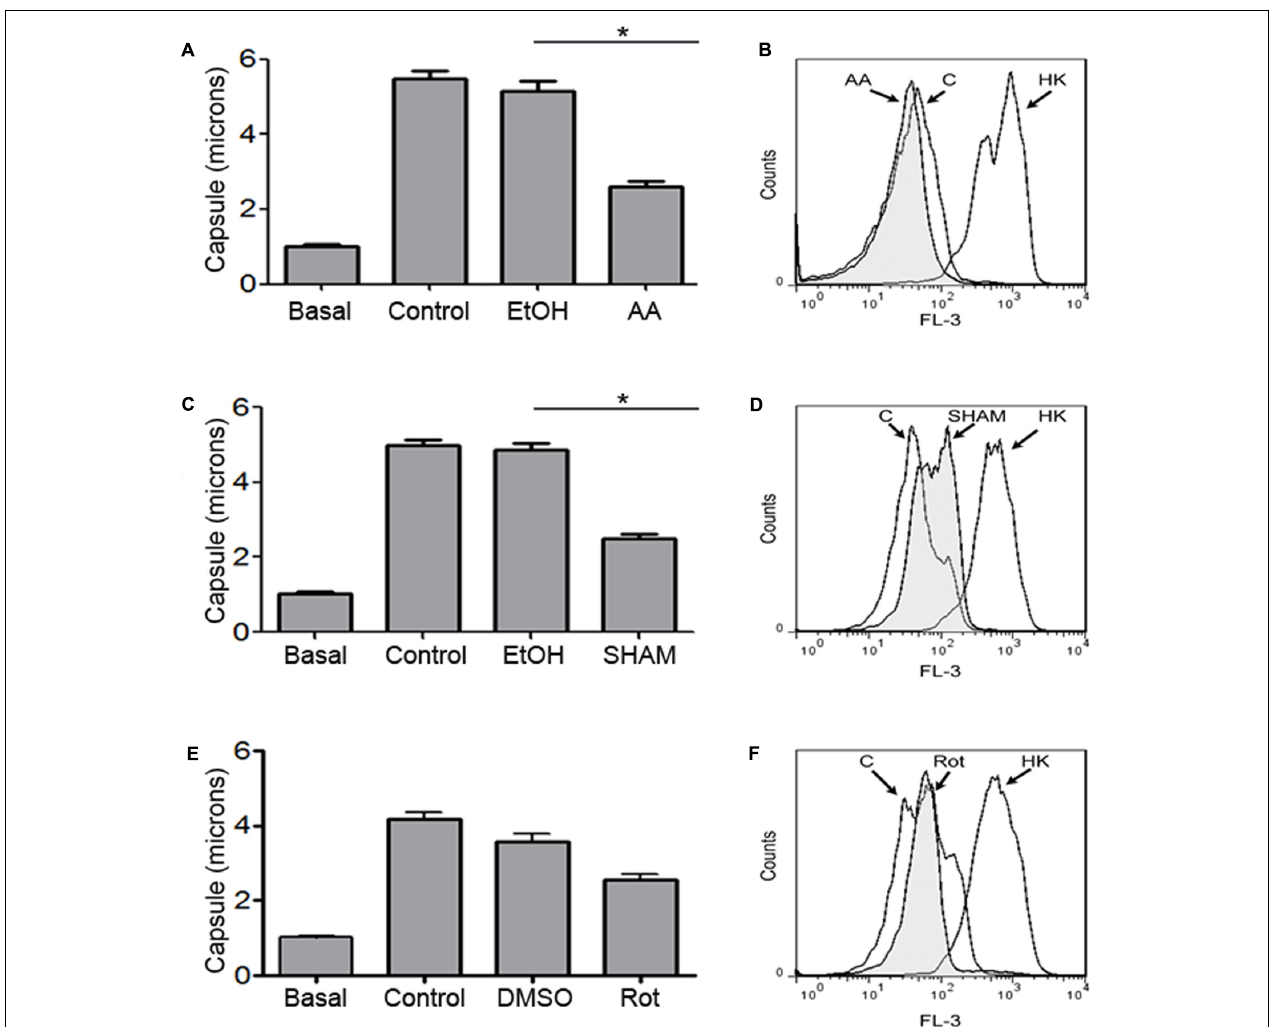
FIGURE 3 | Effect of mitochondrial inhibitors during capsule induction. Cells from H99 strain were grown in Sabouraud liquid medium at 30 ◦ C (basal) and then transferred to 10% Sabouraud buffered at pH 7.3 with 50 mM MOPS in the presence of the highest concentration of antimycin A (3.6 µ M) (A,B) , SHAM (4 mM) (C,D) , and rotenone (250 µ M) (E,F) for 18 h. In each case, control samples incubated only with the solvent (EtOH or DMSO) or without any solvent (control) were carried out in parallel. After the incubation time, capsule size (A,C,E) was measured by suspending the cells in India ink as described in Section “Materials and Methods.” Asterisks indicate significant differences ( p < 0.05). In parallel, cellular viability was determined by measuring the uptake of propidium iodide by dead cells by flow cytometry (B,D,F) . Heat-killed cells (HK) were included as positive controls. The experiment was performed in